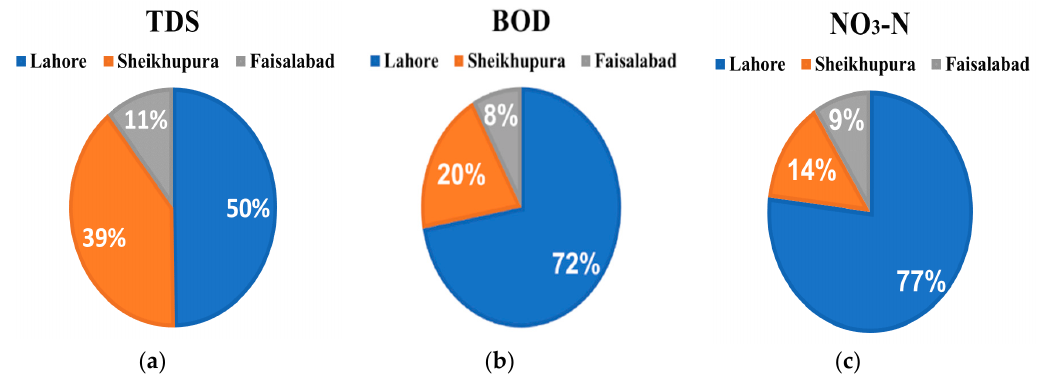
Figure 8. District wise pollution load share of water-quality variables: ( a ) TDS, ( b ) BOD, and ( c ) NO 3 -N along the Ravi River .